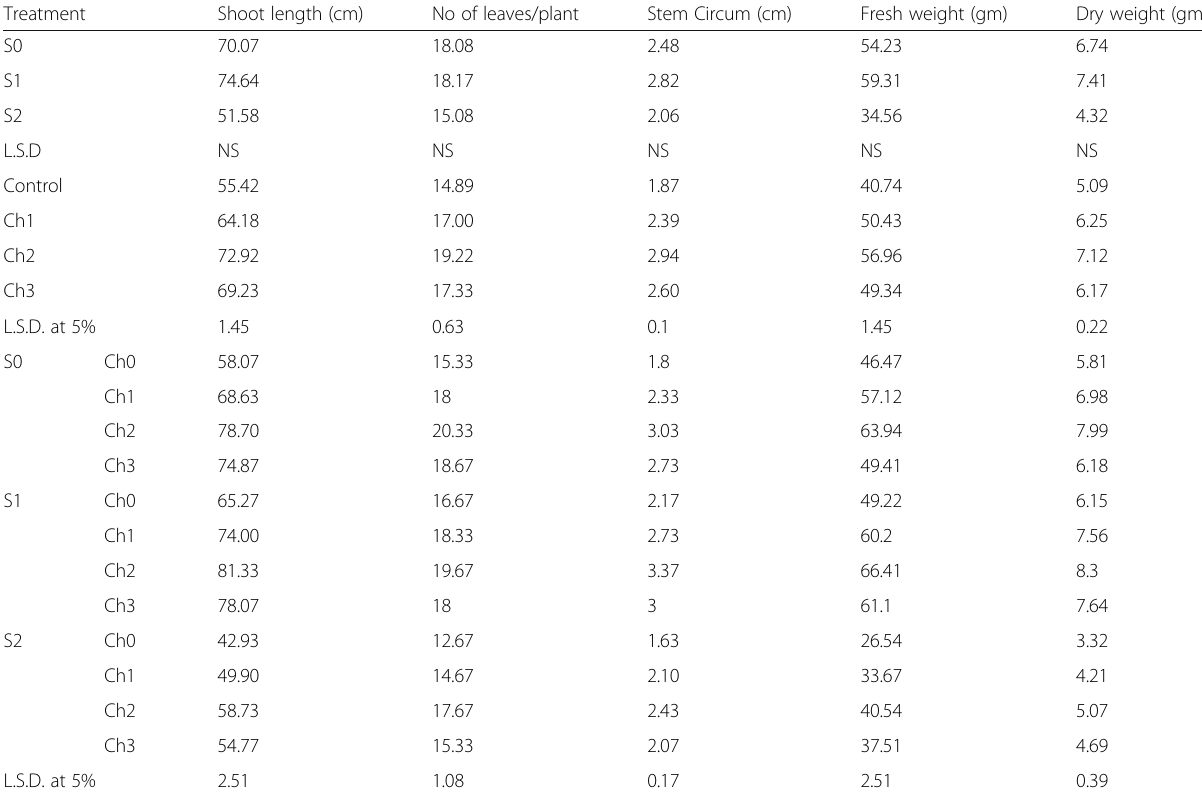
Table 2 Effect of salt stress (S0, S1, and S2), chitosan concentration (Ch0, Ch1, Ch2, and Ch3) and their interaction on growth characters of sunflower plant (data are means of two seasons)